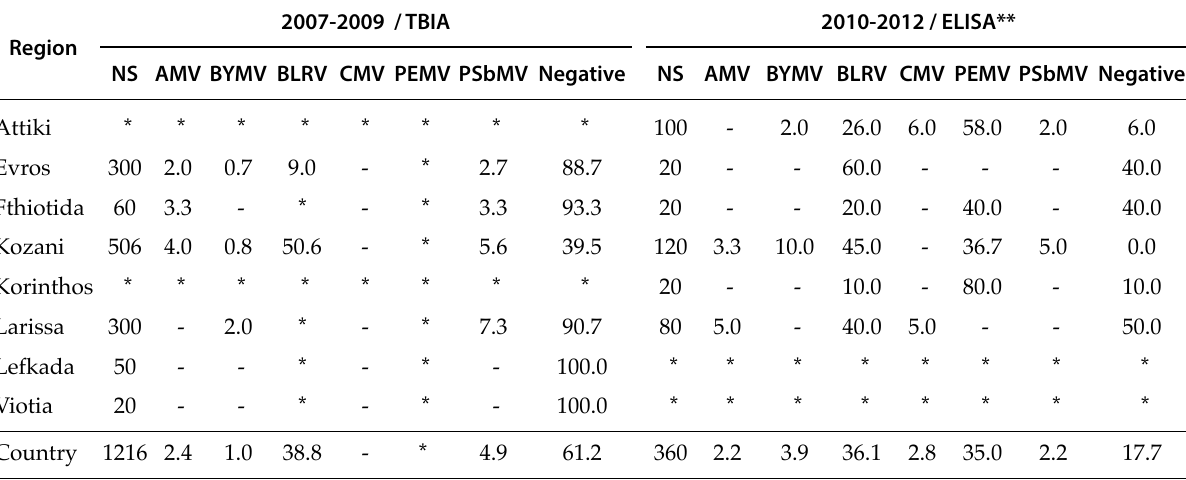
NS = number of samples tested Negative = % of samples negative to all antisera used * = no sampling/testing performed, - = not detected, ** All samples were negative to BBSV Virus acronyms used are: AMV = Alfalfa mosaic virus , BBSV = Broad bean stain virus , BYMV = Bean yellow mosaic virus , BLRV = Bean leafroll virus , CMV = Cucumber mosaic virus , FBNYV = Faba bean necrotic yellows virus, PEMV = Pea enation mosaic virus-1 , PSbMV = Pea seed-borne mosaic virus